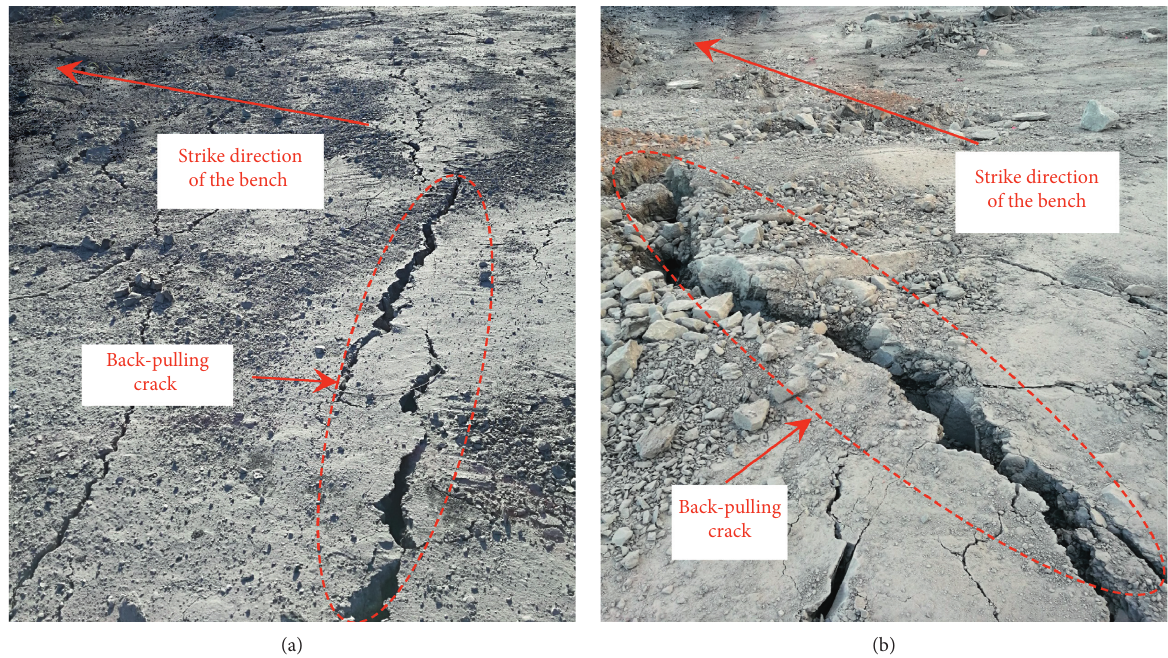
Figure 17: Comparative analysis of the back-pulling situation of the bench rock. (a) Back-pulling situation of the test group. (b) Back- pulling situation of the control